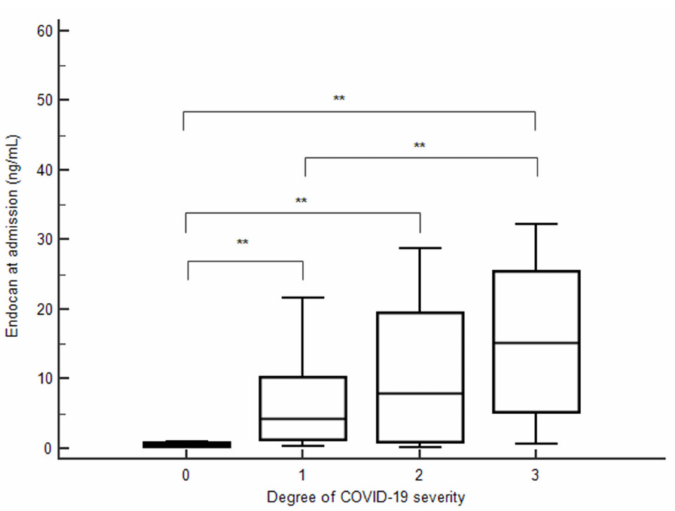
Figure 3. Endocan concentrations at admission according to COVID-19 severity. **, p < 0.05.